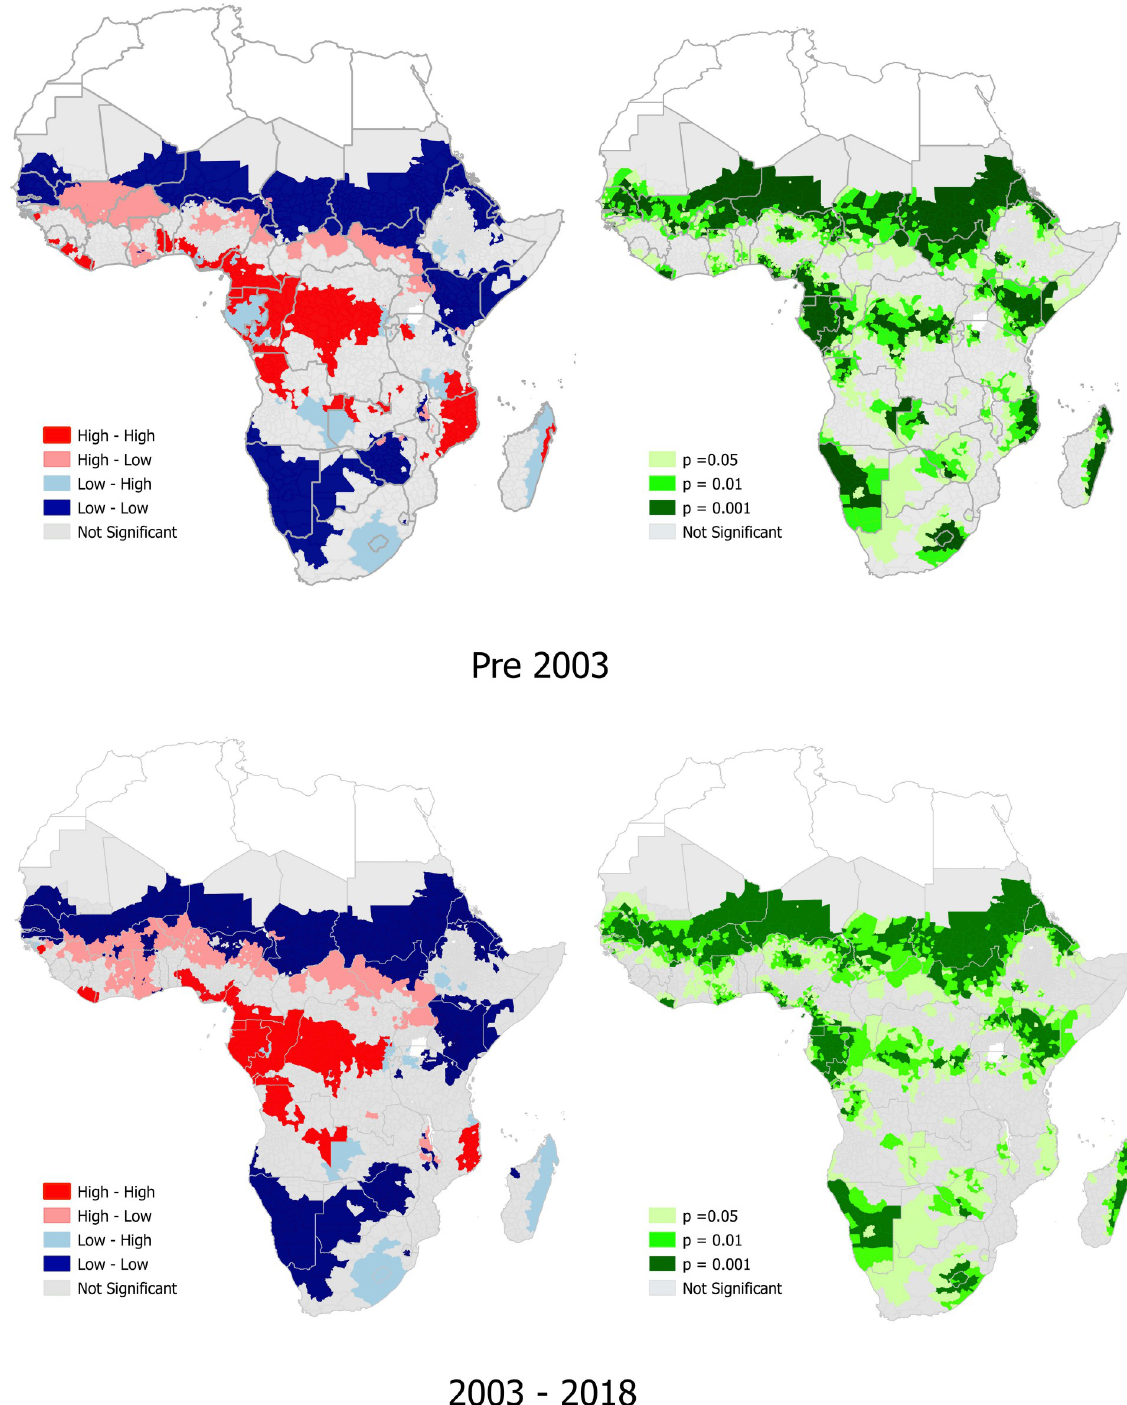
Fig 1. The prevalence of P . falciparum and any soil-transmitted helminth co-endemicity, and significant hotspots of P . falciparum and any soil-transmitted co-endemicity in sub-Saharan Africa. The density description next to the colour-coded box refers to the prevalence of P . falciparum , whilst the column further to the right refers to density of any STH. Link to the base layer of the map: https://gadm.org/index. html.